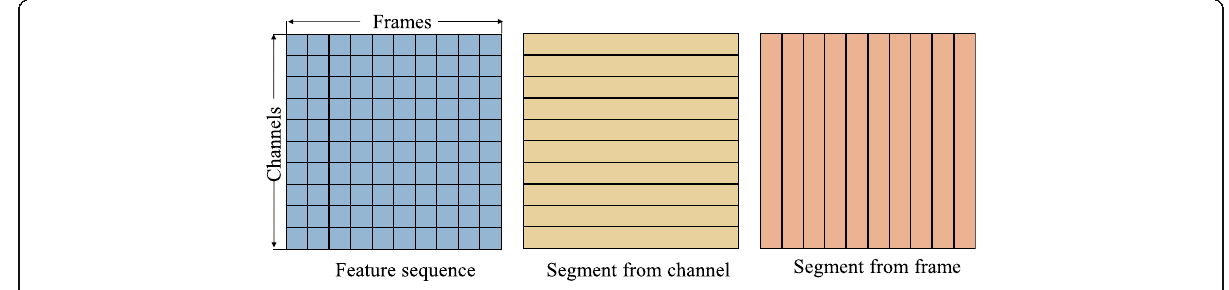
Fig. 2 Feature sequence segmented by channel dimension or frame